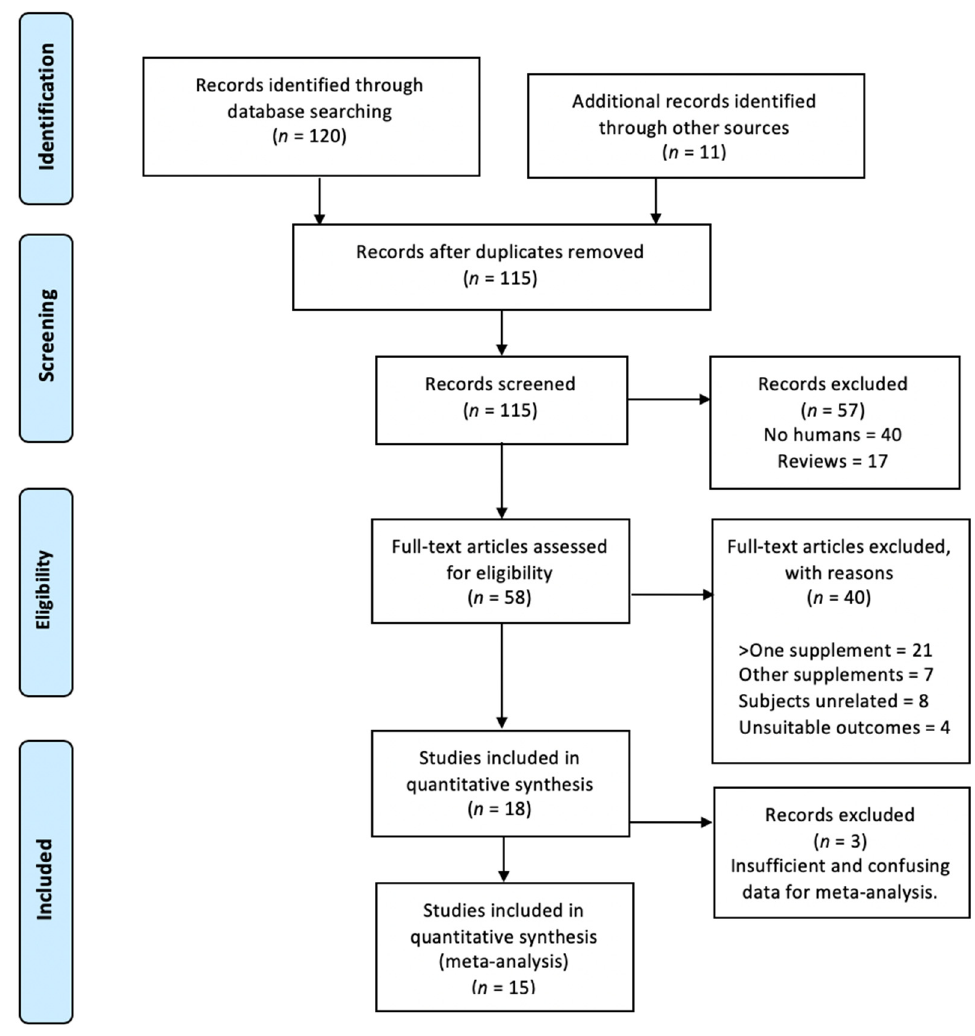
Figure 4. Preferred Reporting Items for Systematic Review and Meta-Analyses (PRISMA) flow diagram.